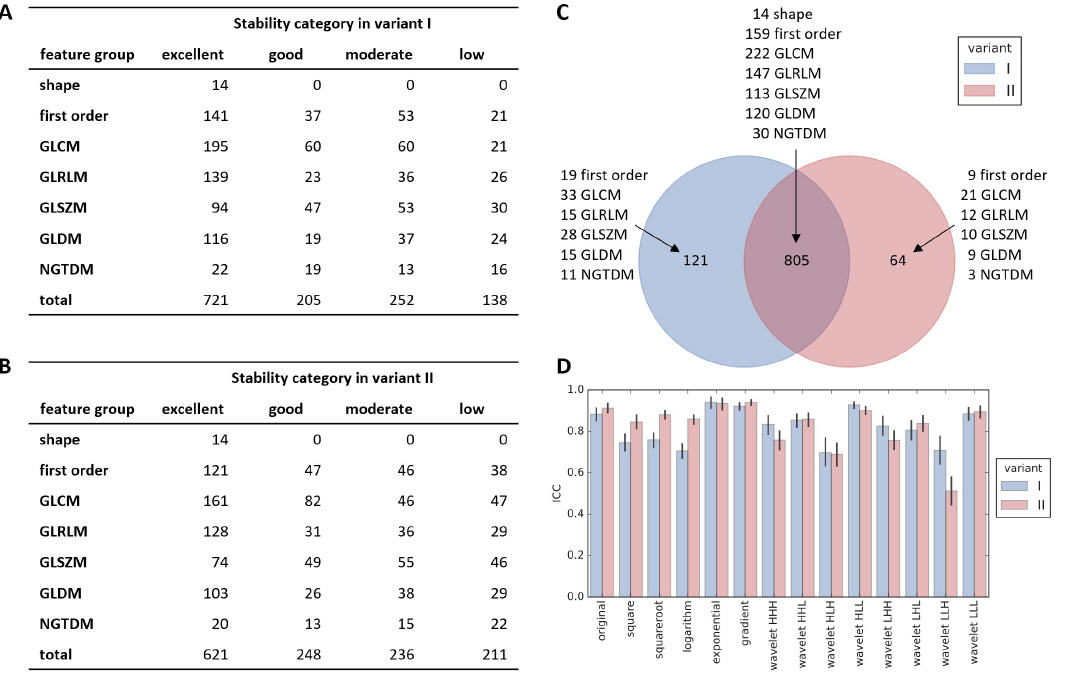
Figure 2. Results of feature stability assessment. Number of features in each group classified to different stability categories for variant I ( A ) and II ( B ). Overlap of features with at least good stability between variant I and II ( C ). Average stability of all radiomic features with respect to applied image filter ( D , shown mean with 95% confidence